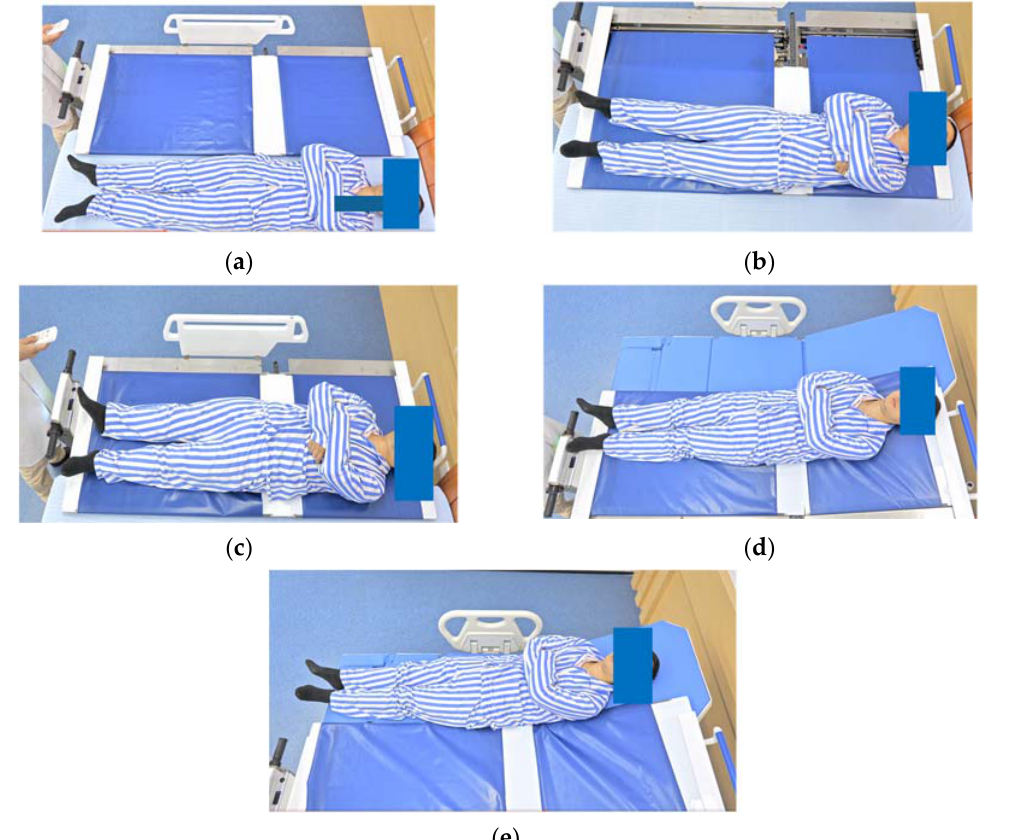
Figure 17. Prototype of the patient transfer robot. ( a ) Body of the patient transfer robot; ( b ) touch-screen control; ( c ) remote control.